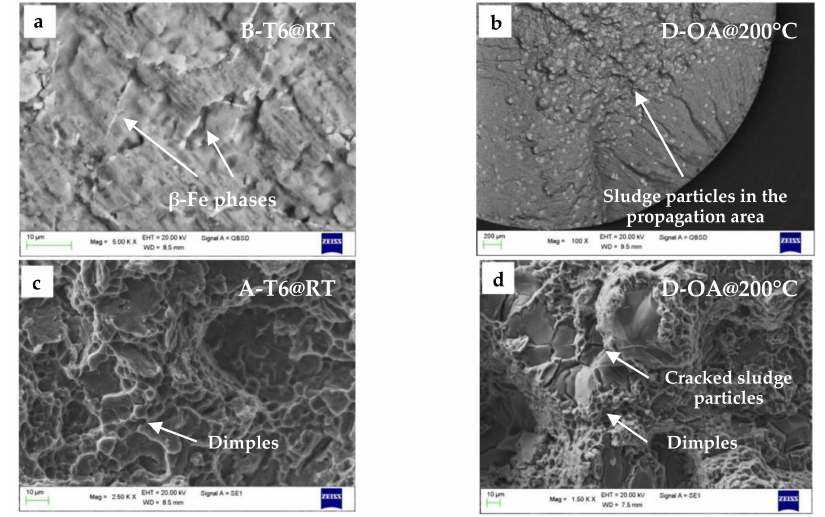
Figure 9. SEM images of fracture surfaces, showing ( a ) β -Fe phases in the propagation area of a B-T6 sample; ( b ) a dense population of sludge particles in the propagation area of D-OA alloy; ( c ) ductile morphology of final failure region in A-T6 alloy and ( d ) final failure area of D-OA alloy tested at 200 ◦ C characterized by cracked sludge particles and